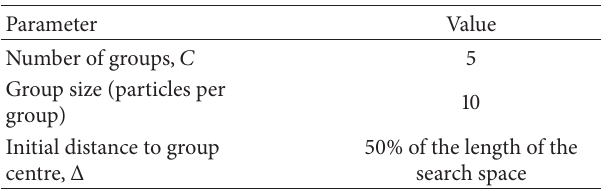
Table 2: Parameters setting for the additional parameters in SA-